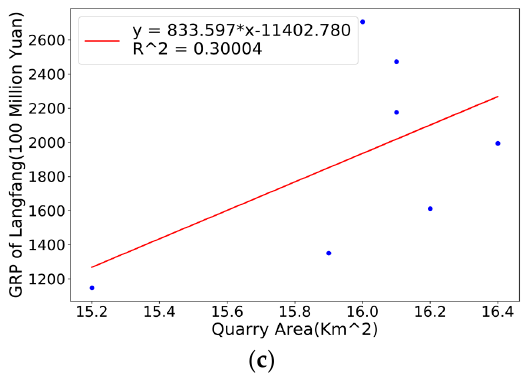
Figure 11. ( a ) Line charts of gross regional products (GRP) in Langfang and the quarry area in Langfang; ( b ) The scatter diagram of the regression variables before 2009; ( c ) The scatter diagram of the regression variables after 2009.